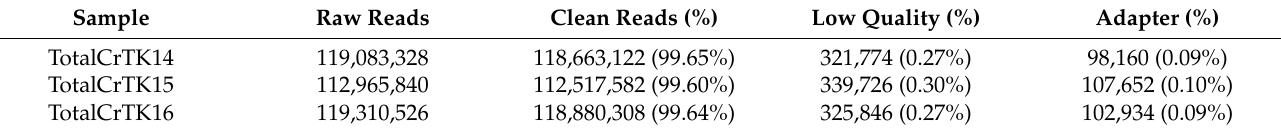
Table 2. Raw reads and clean reads of the RNA-sequencing of the CR of M . reevesii .